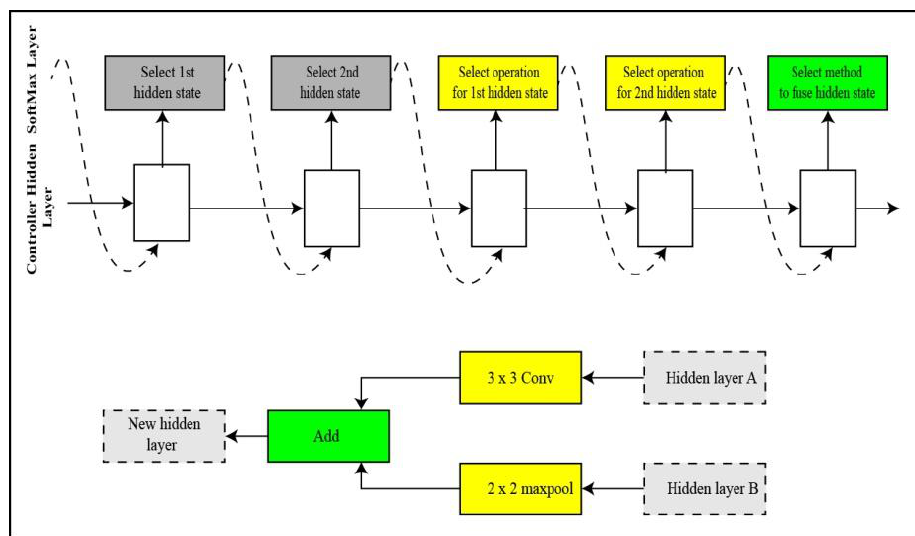
Figure 6. Illustration of controller process for NasNet large.